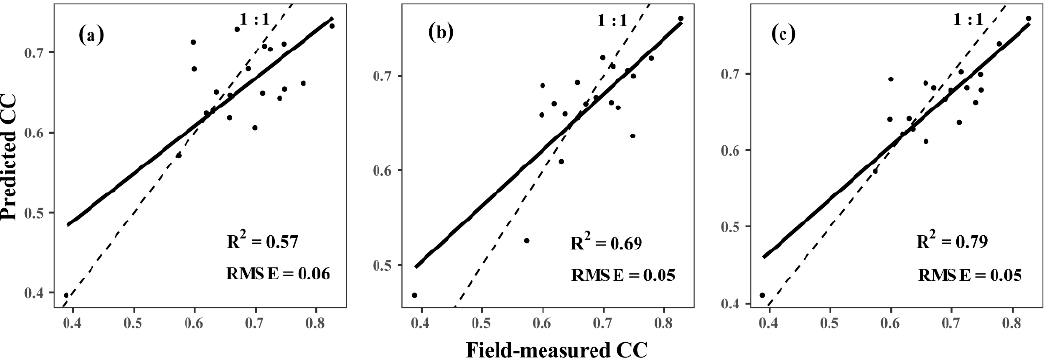
Figure 5. Plots of the observed and predicted CC using RF with ( a ) Model 1; ( b ) Model 2; and, ( c ) Model 3.